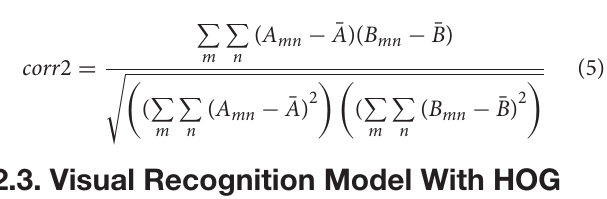
pixel was weighted and projected along the gradient direction; it was subsequently mapped within the block corresponding to the calculated angle. Next, a histogram of the gradient direction of the block and window were collected. Finally, the feature vectors of all the windows were concatenated, and the HOG feature of the entire image was obtained as a feature array. extract the feature vectors of the current testing image and all of the training sets. Figures 5A,B represent the HOG feature vectors of a training image (left) and a testing image (right), respectively. Correlations between HOG features of